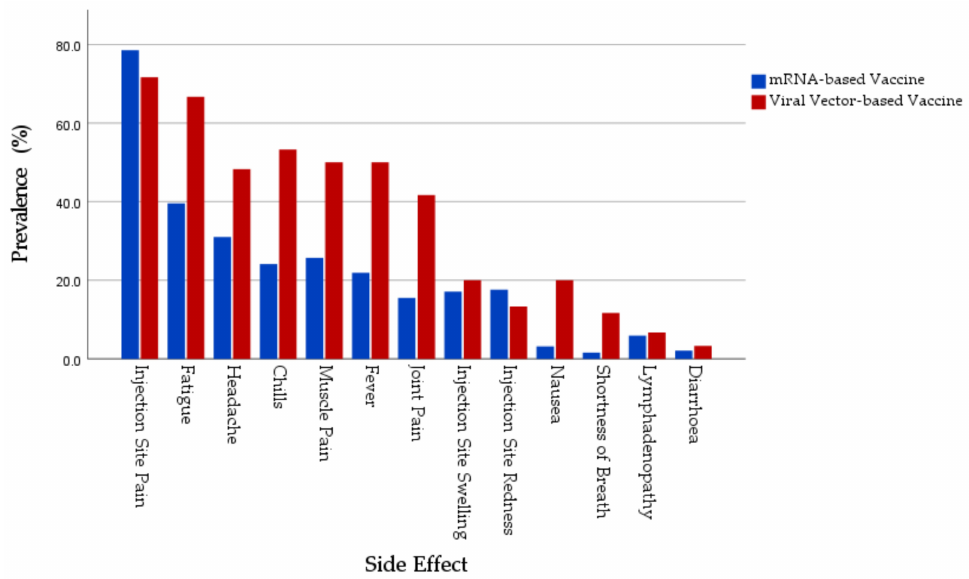
Figure 1. Prevalence of COVID-19 vaccines SRAEs reported by Polish healthcare workers. Among the mRNA-based vaccine recipients, 45.1% reported systemic adverse events exclusively after the second dose and 39.2% reported them after both doses. A vast majority (84.8%) of systemic SRAEs resolved within 1–3 days after receiving the vaccine. There was no significant difference between the mRNA-based and the viral vector-based vaccine groups in terms of systemic SRAEs duration (Table 5). Table 5. Systemic adverse effects of COVID-19 vaccines reported by Polish healthcare